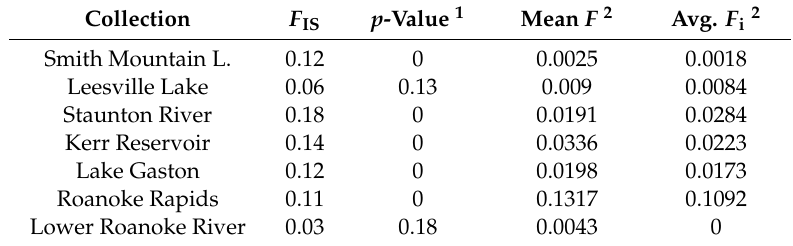
Table 10. Levels of inbreeding for Roanoke basin striped bass collections estimated using two